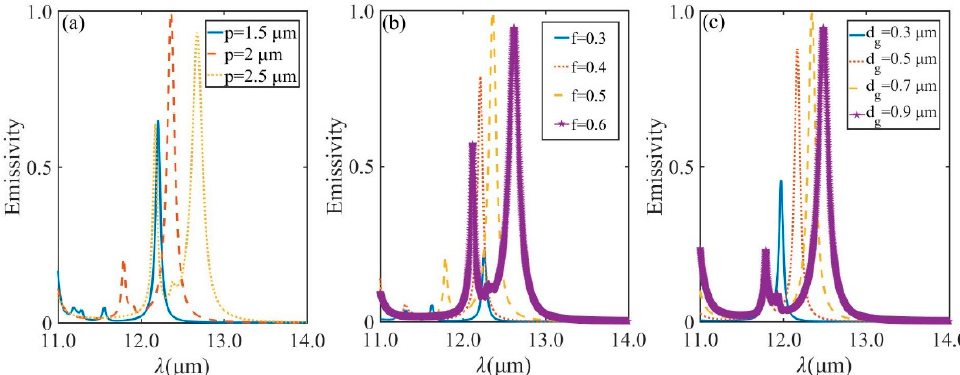
Figure 8. ( a ) Emission spectra under normal incidence for TM polarization with 5 DBR pairs when f = 0.5 and d g = 0.7 μ m with grating period p of 1.5 μ m, 2 μ m, 2.5 μ m, respectively. ( b ) Emission spectra under normal incidence for TM polarization with 5 DBR pairs with p = 2 μ m and d g = 0.7 μ m when f = 0.3, f = 0.4, f = 0.5, f = 0.6, respectively. ( c ) Emission spectra under normal incidence for TM polarization with 5 DBR pairs with p = 2 μ m and f = 0.5 with grating depth d g =0.3 μ m, d g = 0.5 μ m, d g = 0.7 μ m, d g = 0.9 μ m, respectively. Figure 9a,b present the wavelength and angle-dependent emission of the SiC-based structure with p = 2 μ m, f = 0.5, d g = 0.7 μ m and d s = 0.75 μ m. Near-unity absorption for both TE and TM polarization has been achieved for angles less than 80°. For angles larger than 80°, the intensity of resonance decreases significantly for TE polarization, while can